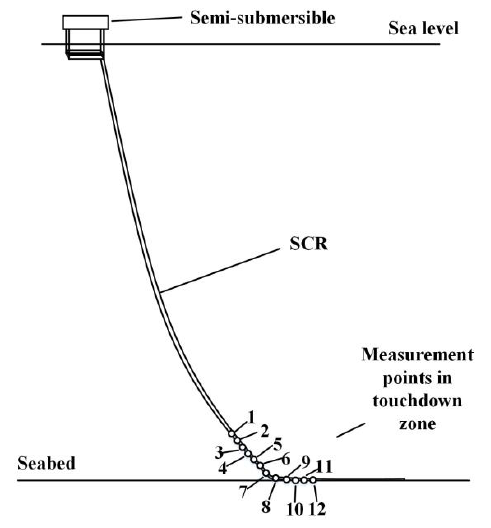
Figure 5. Locations of SCR measurement points. Table 3. SCR touchdown zone measurement points location arrangement.